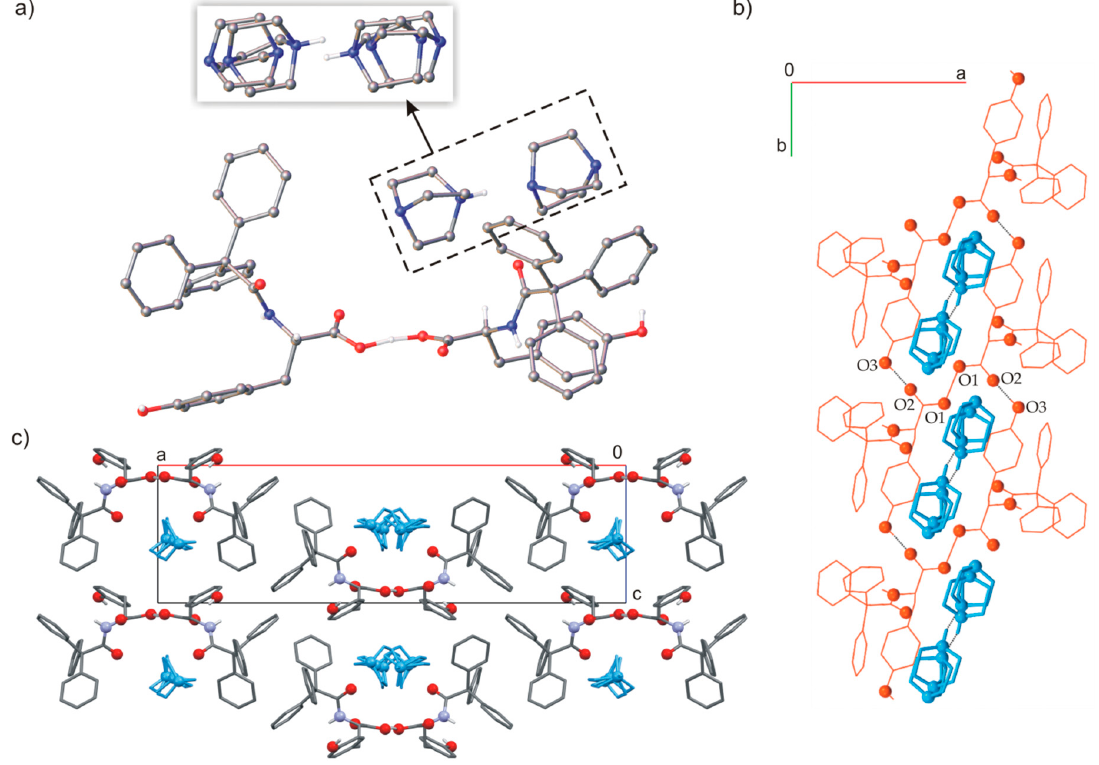
Figure 8. ( a ) Molecular structure of TrCOTyr · DABCO (model of disorder for the DABCO dimer shown in the frame), ( b ) molecular gutter filled by DABCO cationic dimers, ( c ) molecular packing in crystal